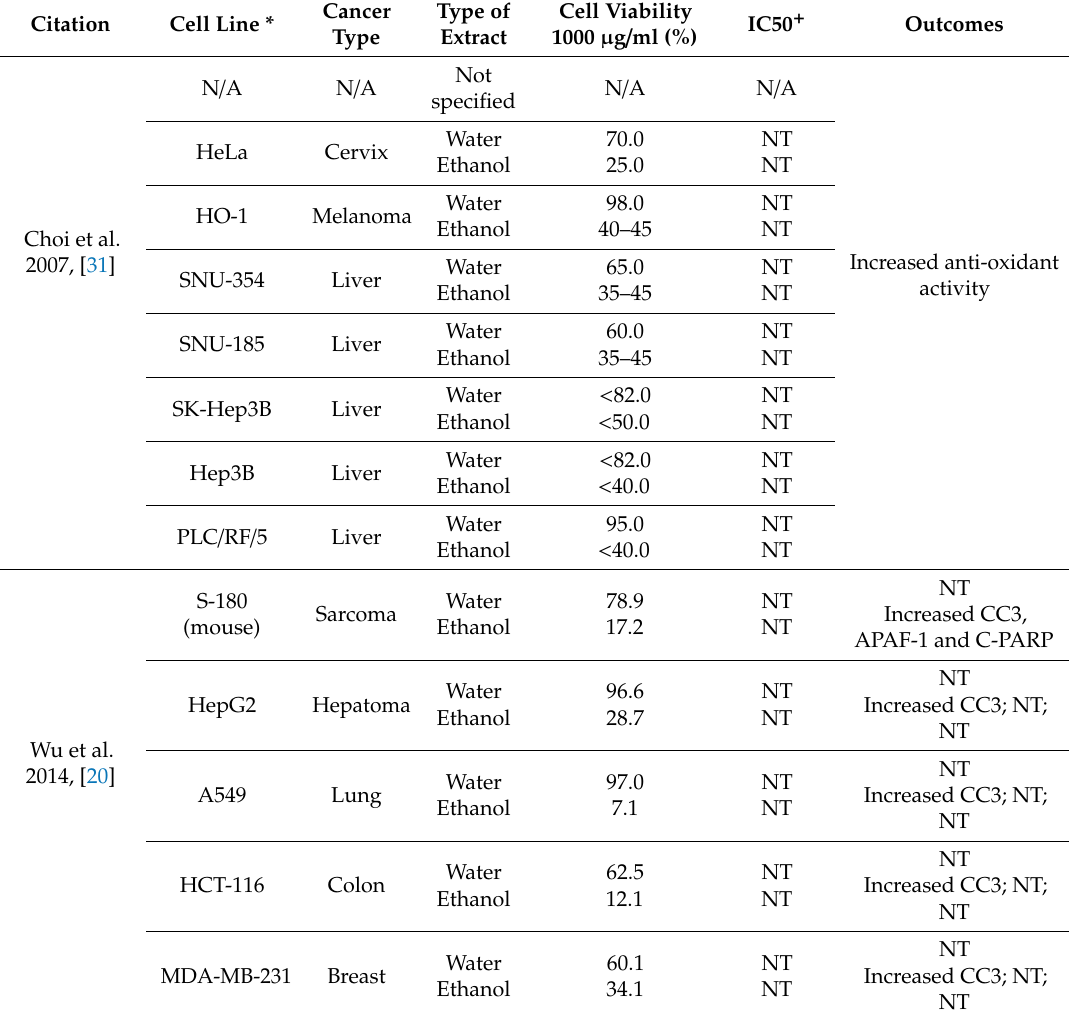
Table 2. In vitro studies in which the anti-cancer properties of F. pinicola were